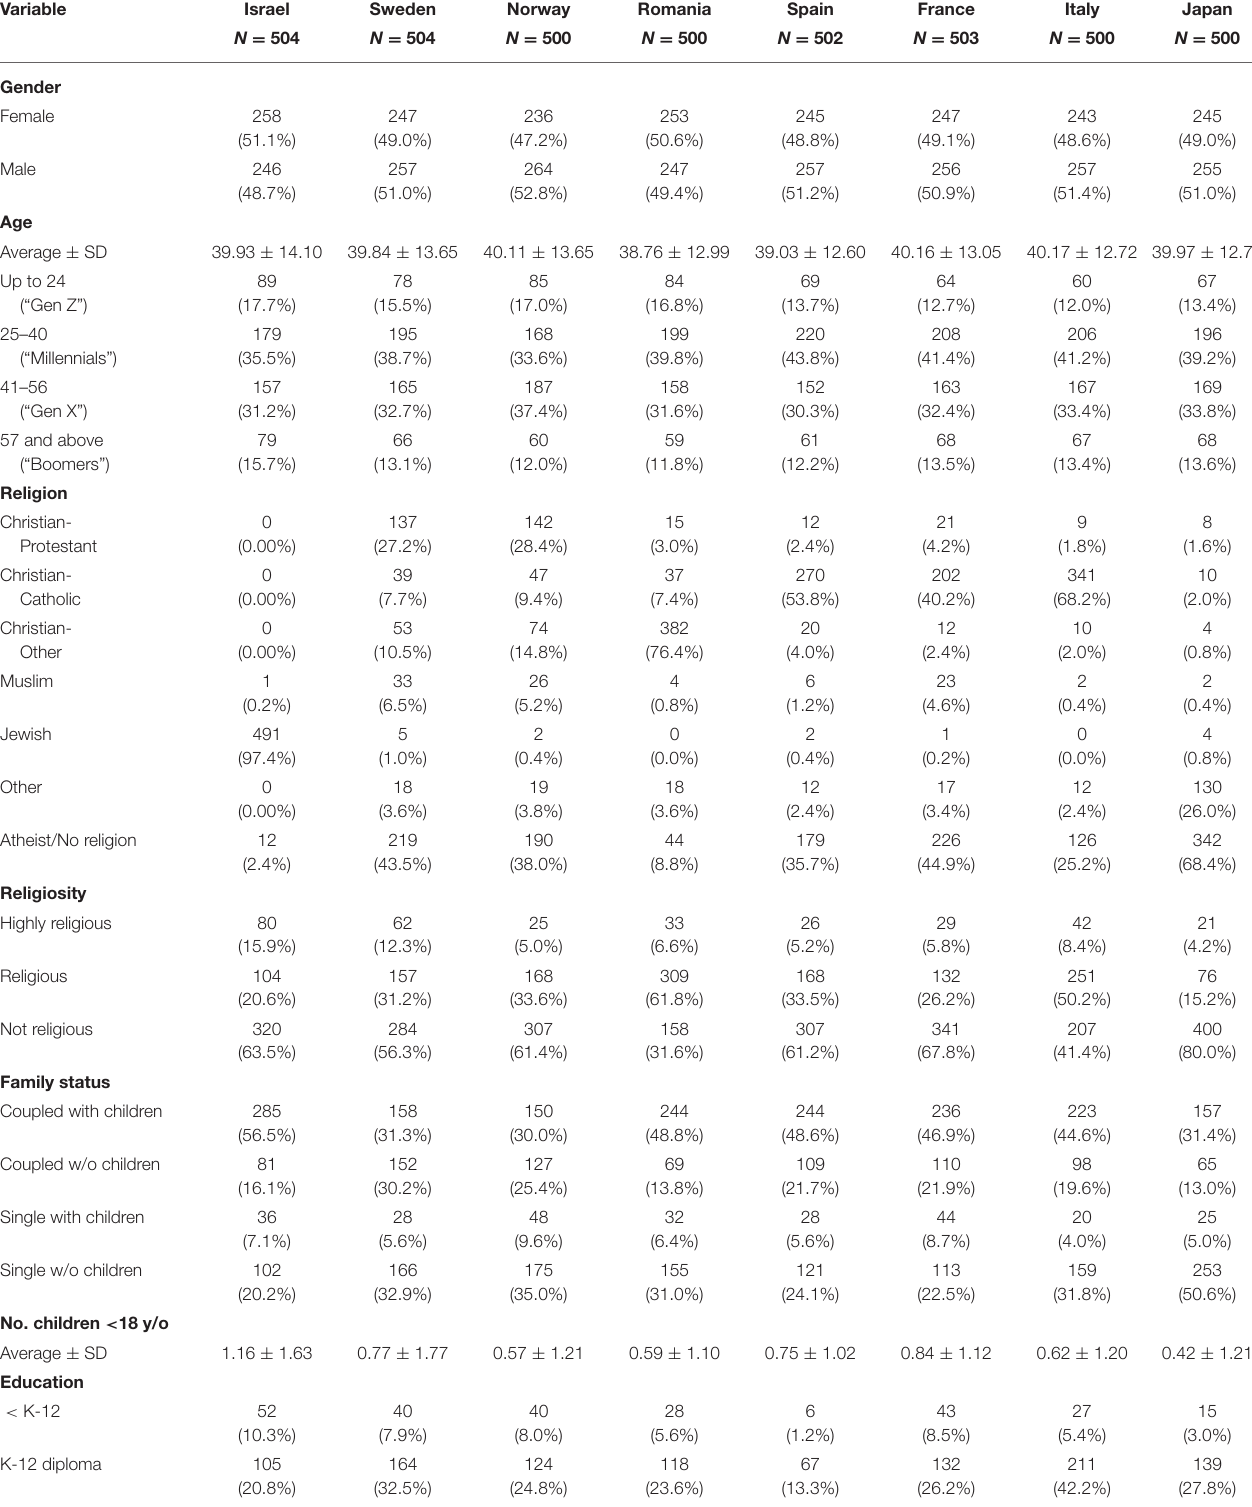
TABLE 1 | Socio-demographic breakdown of the studied sample ( N = 4,013).